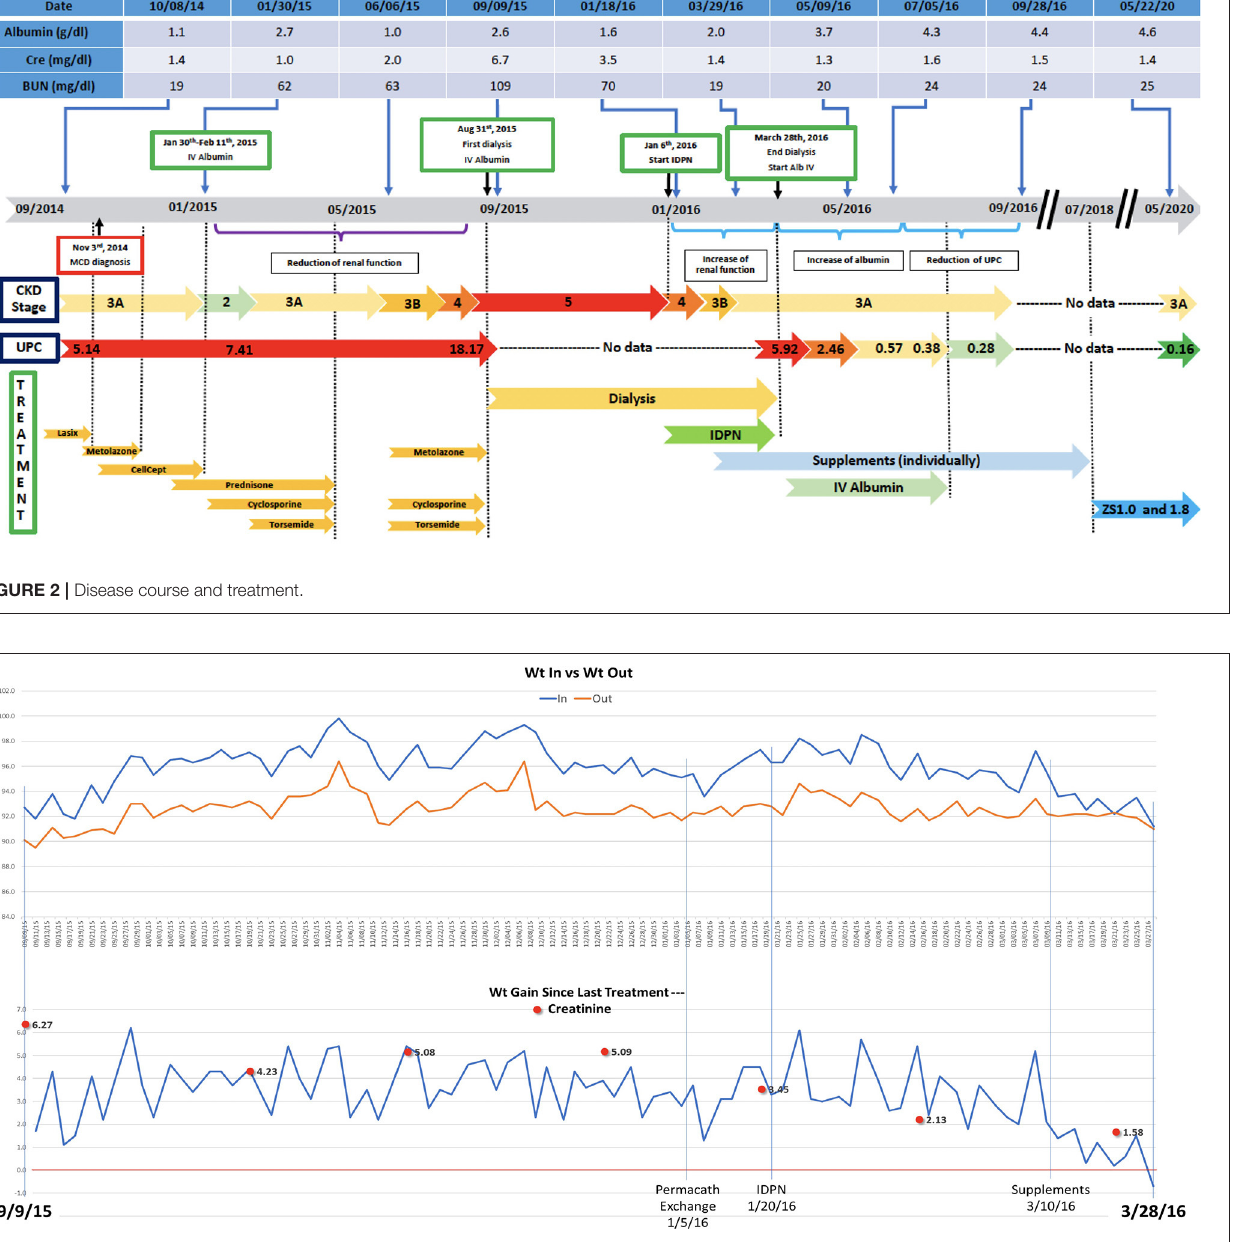
FIGURE 3 | Dialysis timeline and